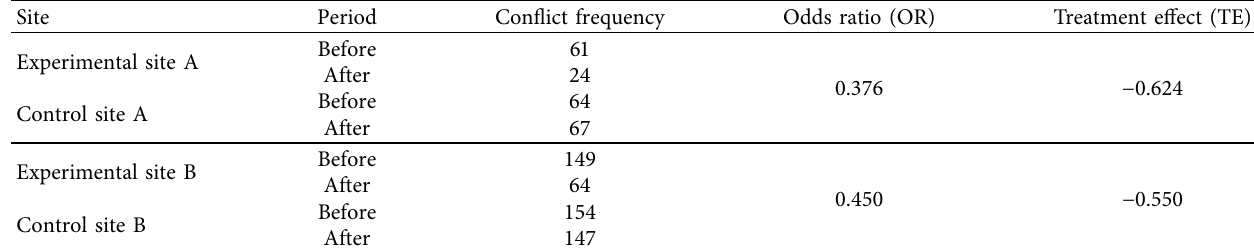
Table 3: Odds ratio and treatment efect at site pairs A and B.